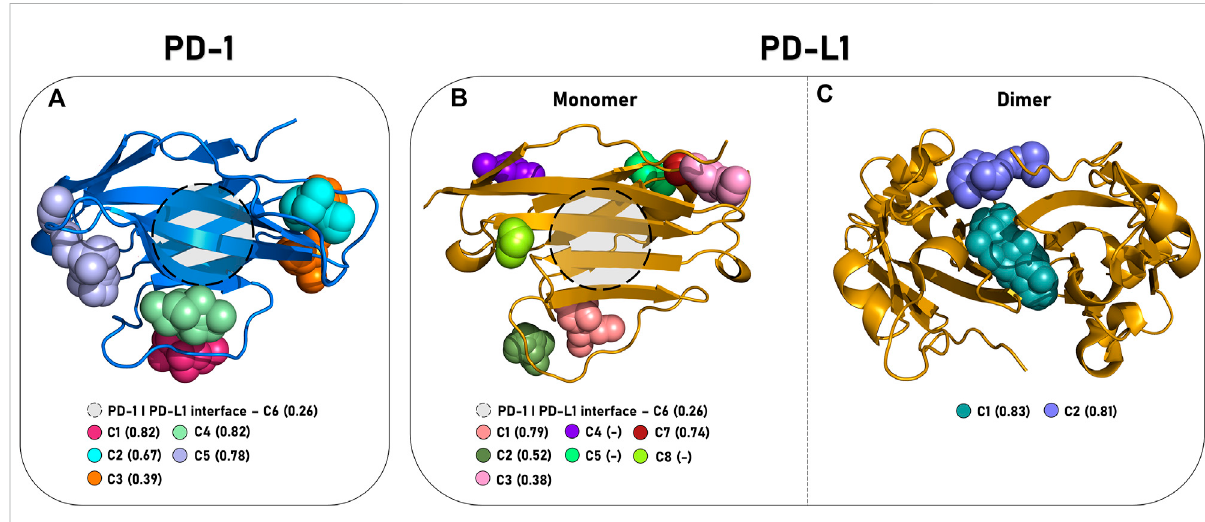
FIGURE 4 PositioningoftheinteractionpocketsinPD-1andPD-L1.Themaincavitiesof (A) PD-1(cartoon,blue), (B) PD-L1 m (cartoon,yellow),and (C) PD- L1 d (cartoon, yellow) are represented by colored spheres, and the druggability score descriptor obtained from the DoGSiteScorer web server is shown in parenthesis. (-) de fi ne cavities not identi fi ed by the server.